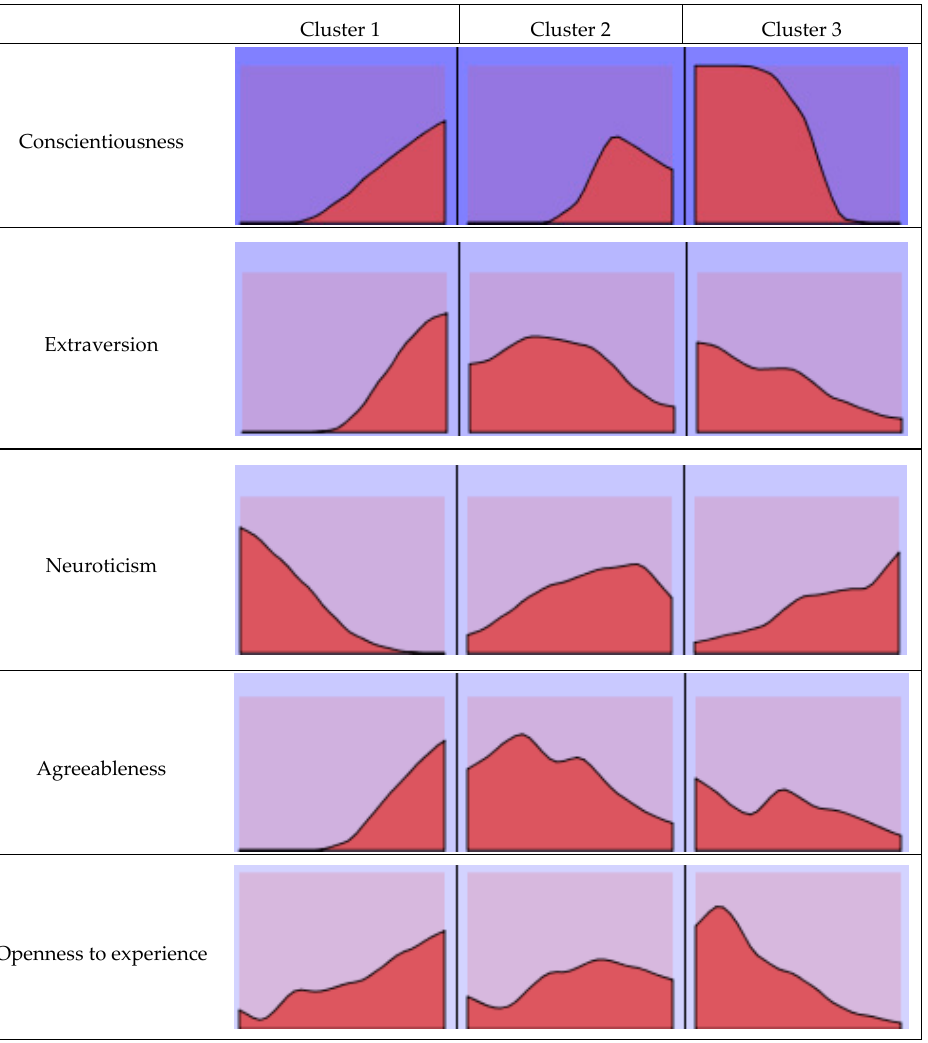
Figure 2. Cluster composition ( N = 1236). The factors were organized in order of importance of input.